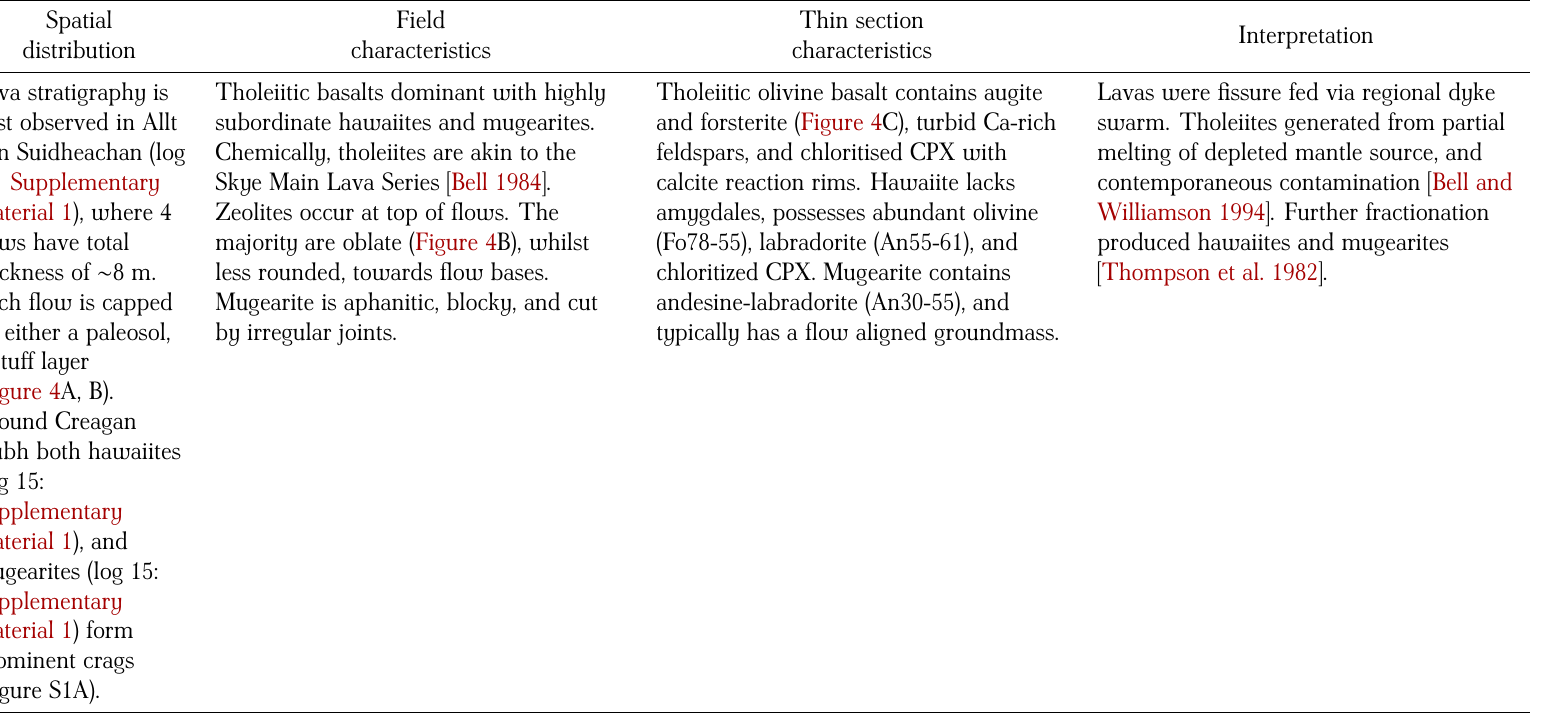
Table 1: Basic lavas, paleosols, ash horizons, and peperite of the